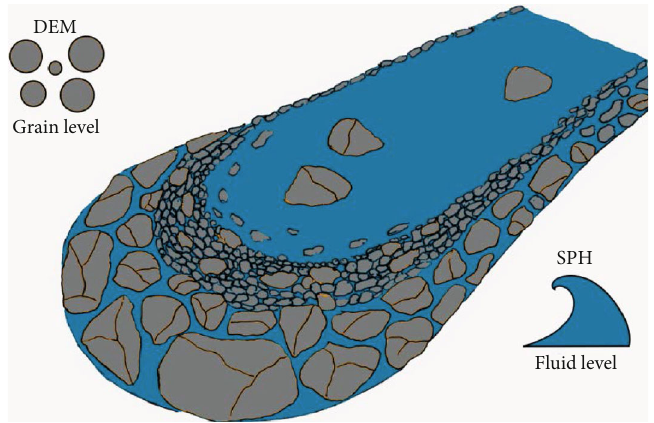
Figure 1: Schematic diagram of SPH-DEM simulation of the solid-liquid two-phase debris fl